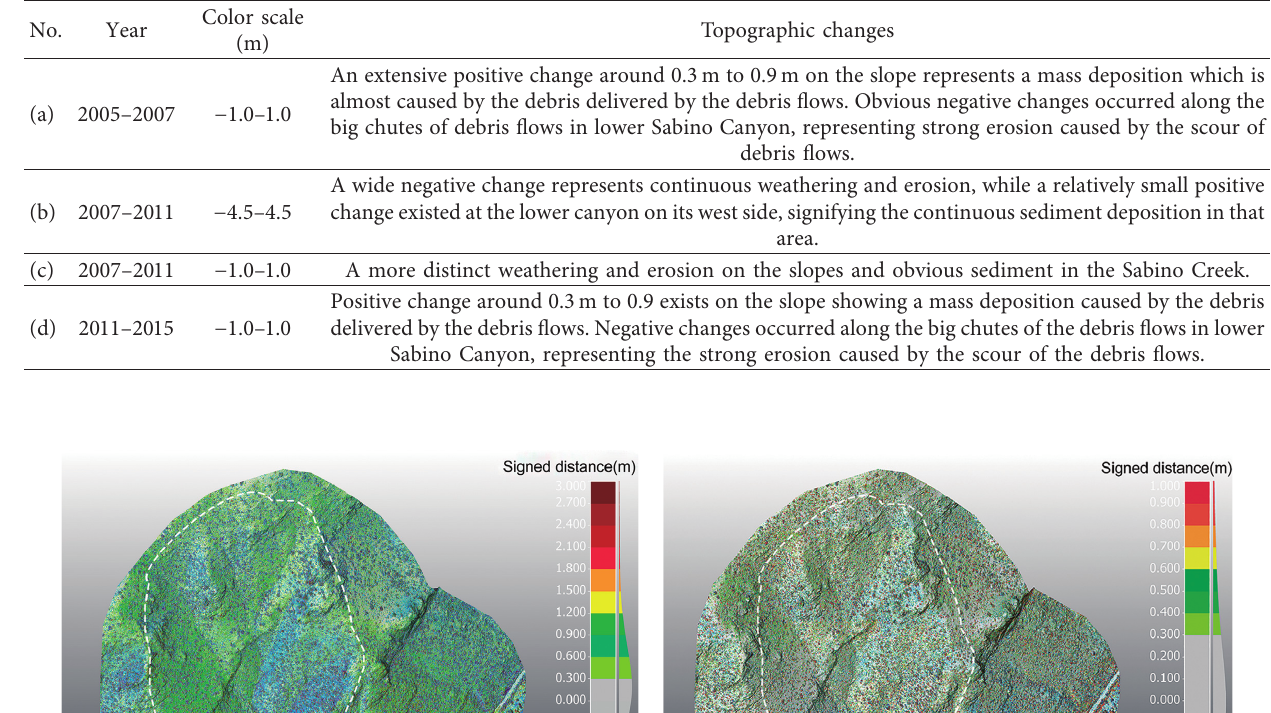
Table 2: Change detection results of debris